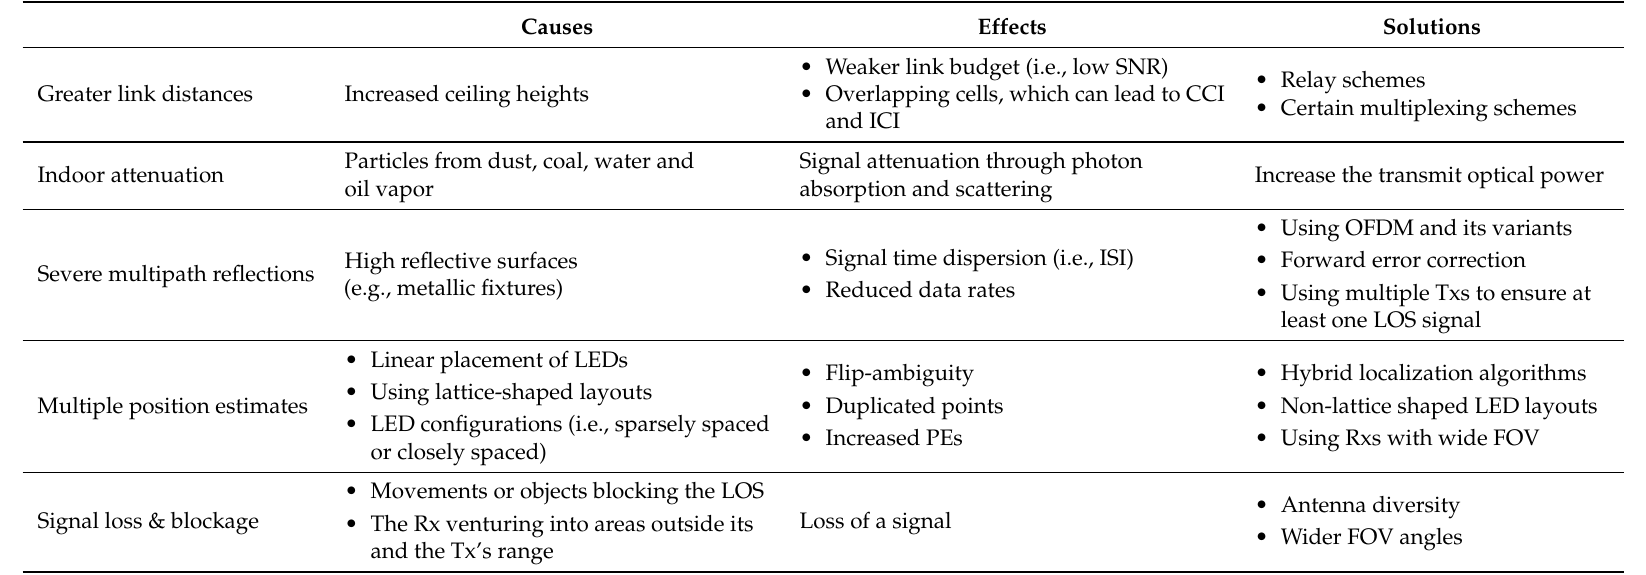
Table 5. Challenges for Visible Light Communication (VLC) systems in industrial